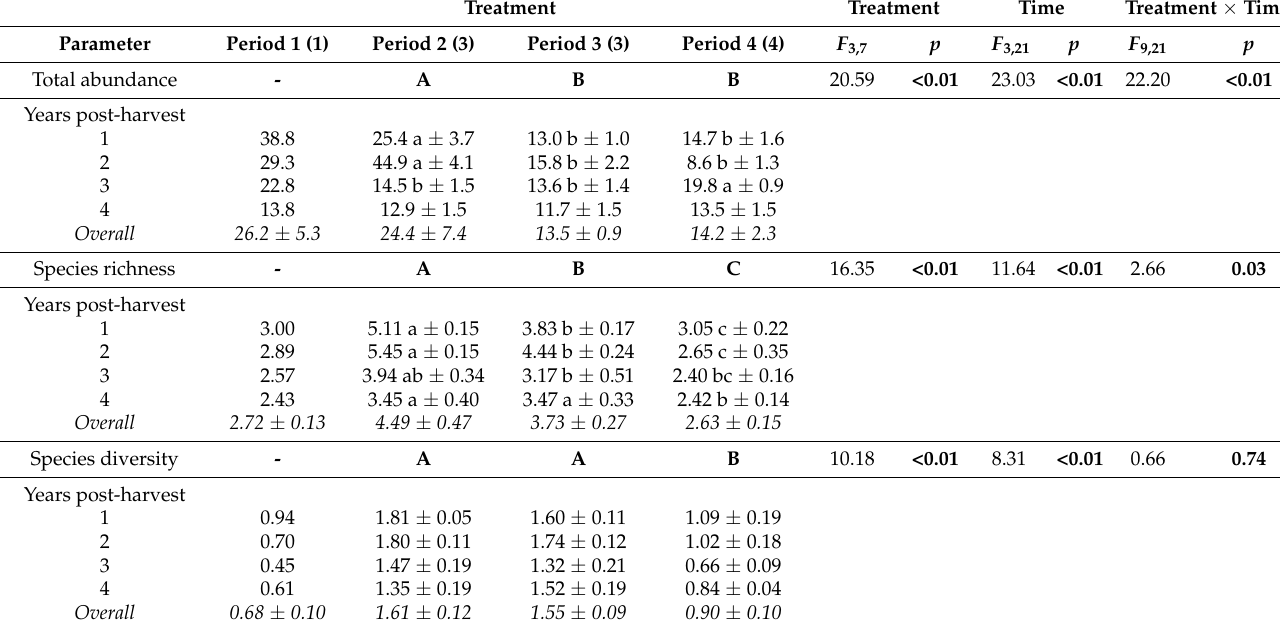
Table 2. Mean ( n = 1, 3 or 4 replicate sites) ± SE annual total abundance, species richness, and species diversity per ha for forest-floor small mammals during the first four years after clearcutting for each of the four Periods for the LTCC study in southern BC, Canada 1979 to 2020, and results of RM-ANOVA. Within a row, columns of mean values with different letters (upper-case for RM-ANOVA; lower-case for univariate ANOVA) are significantly different by Duncan’s multiple range test (DMRT), adjusted for multiple contrasts. Significant values are given in bold